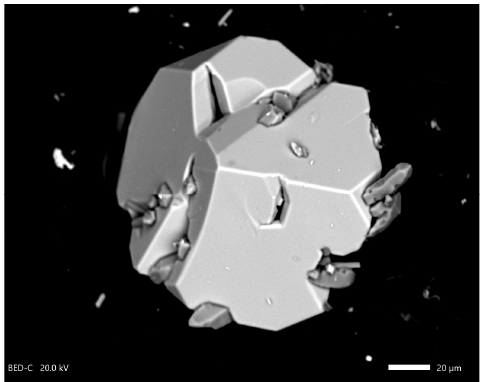
Figure 1. SEM image of the Na 7 V 4 (PO 4 ) 6 crystal with rhombohedral and prismatic faceting. X-ray microprobe spectral analysis was performed at a Jeol JSM-6480LV SEM with an energy-dispersive spectrometer Oxford X-Man N (Laboratory of Analytical Techniques of High Spatial Resolution, Dept. of Petrology, Moscow State University, Russia). EDS analysis revealed that both crystalline phases include V, Na, P, and O atoms. After a preliminary X-ray experiment, yellow isometric crystals were identified as Na 3 V 2 (PO 4 ) 3 with the NASICON structure type [16]. The second black phase of the rhombohedral habitus was diagnosed as a new compound and became the subject of X-ray diffraction analysis and crystal–chemical